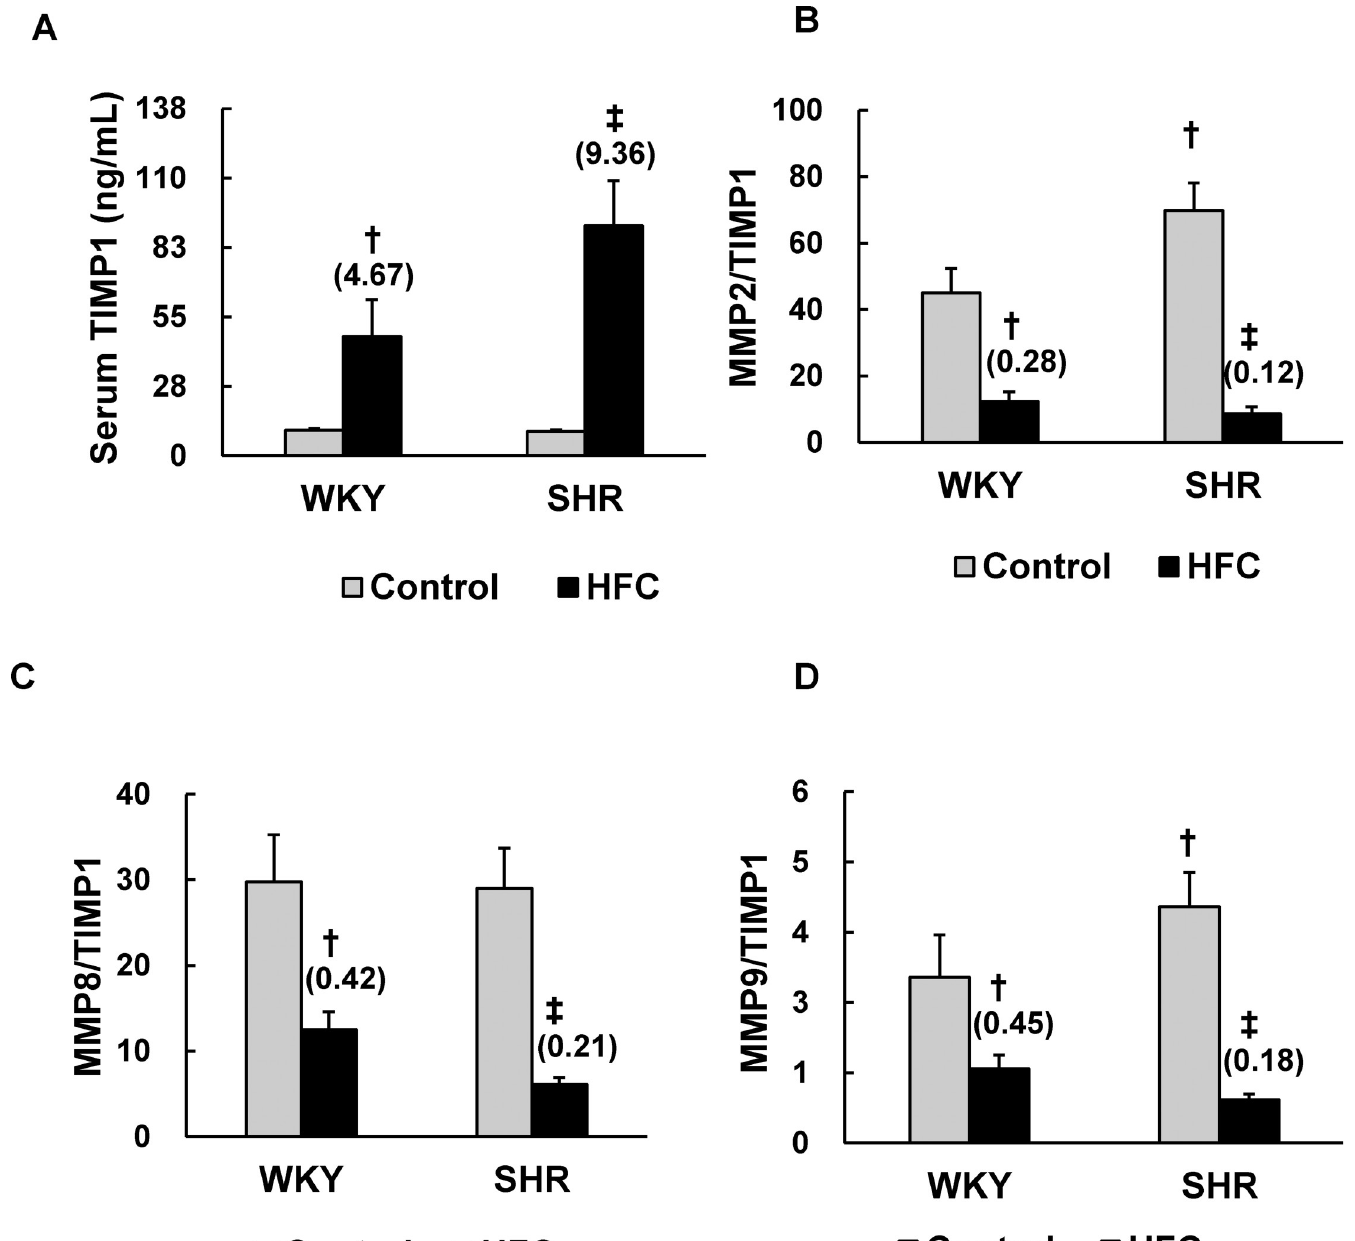
Fig 4. Effects of the HFC diet on serum MMPs/TIMP1. ELISA of serum TIMP1 (A) and MMPs (MMP2, MMP8, and MMP9) (B–D) in WKY and SHRs fed the control or HFC diet. The ratios of MMPs to TIMP1 were calculated as a proxy of MMP activity, n = 6/group. The values in parentheses represent the fold changes compared with the respective control. Significant interaction between stain and HFC diet was observed in serum TIMP1 and ratios of all MMPs to TIMP1. † P < 0.05 vs WKY control diet group (one-way ANOVA); ‡ P < 0.05 vs SHR control diet group (one-way ANOVA). TIMP1, tissue inhibitor of metalloproteinase; MMP, matrix